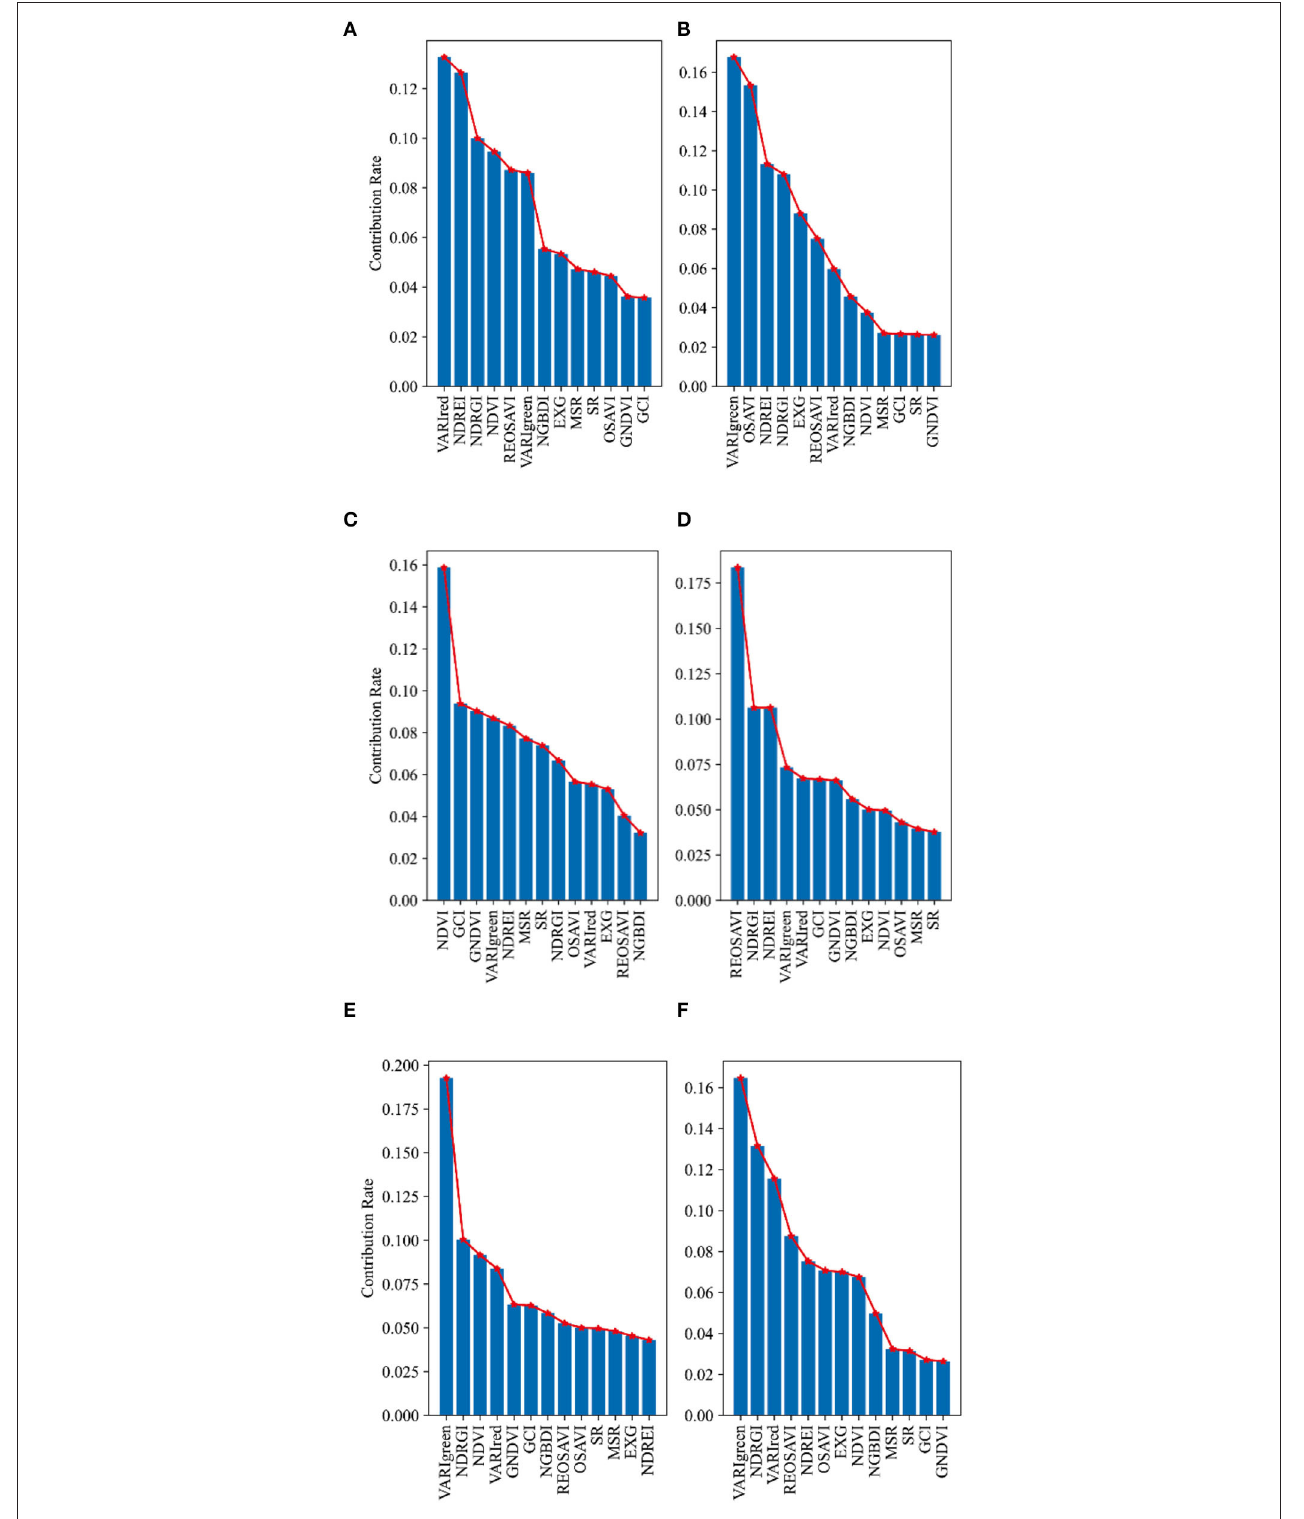
FIGURE 5 | Contribution rate distribution of vegetation indices relative to CC at different growing stages of winter wheat: (A) normal irrigation at heading stage of Manas winter wheat; (B) water limited treatment at heading stage of Manas winter wheat; (C) normal irrigation at flowering stage of Manas winter wheat; (D) water limited treatment at flowering stage of Manas winter wheat; (E) normal irrigation at filling stage of Manas winter wheat; and (F) water limited treatment at filling stage of Manas winter wheat. All vegetation indices that appear in the figure are explained in Table 3 .